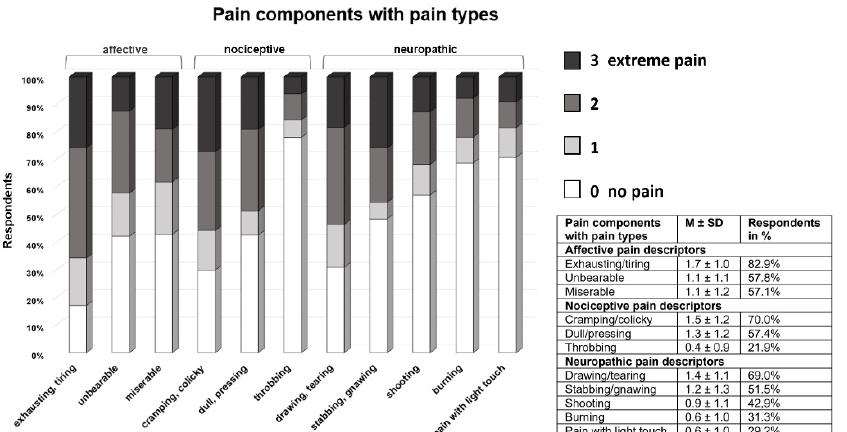
Figure 3. Descriptors of the pain sensations listed in the BPI with means (M) and standard deviations (SD) as well as the percentage of the respondents reporting the respective type of pain. The boxes of each stacked bar graph illustrate the response categories of the respective item from 0 = no pain to 3 = extreme pain. The height of the boxes shows the percentage of respondents who chose the respective response category. The items for pain descriptions are arranged within the respective pain components in descending order of frequency.